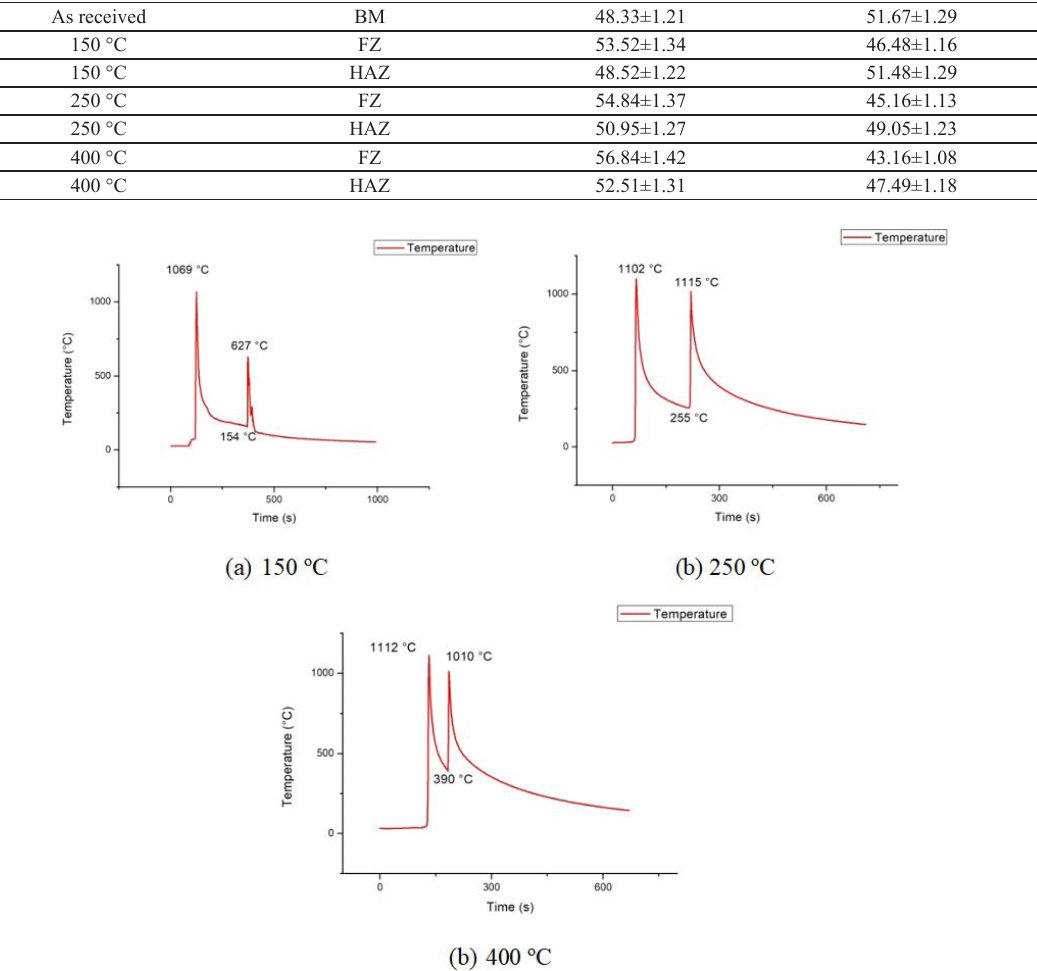
Table 3. Quantitative phase analysis of the welded steel pipes with different interpass temperatures. Inter-pass